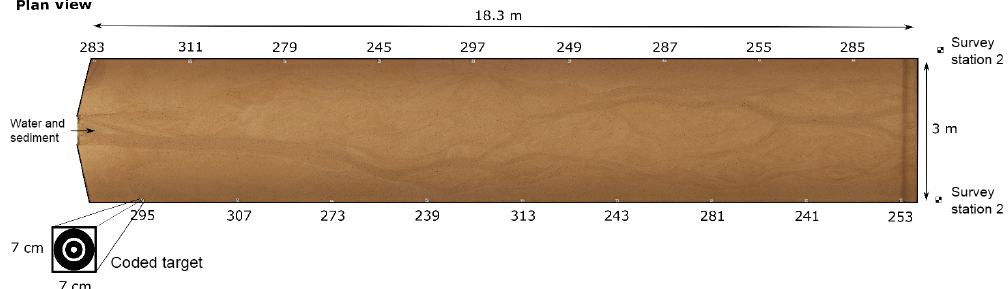
Figure 1. Planform view of the flume showing coded target locations and total station survey locations. Numbers refer to the unique target identifiers used in Agisoft PhotoScan’s automated target detection.